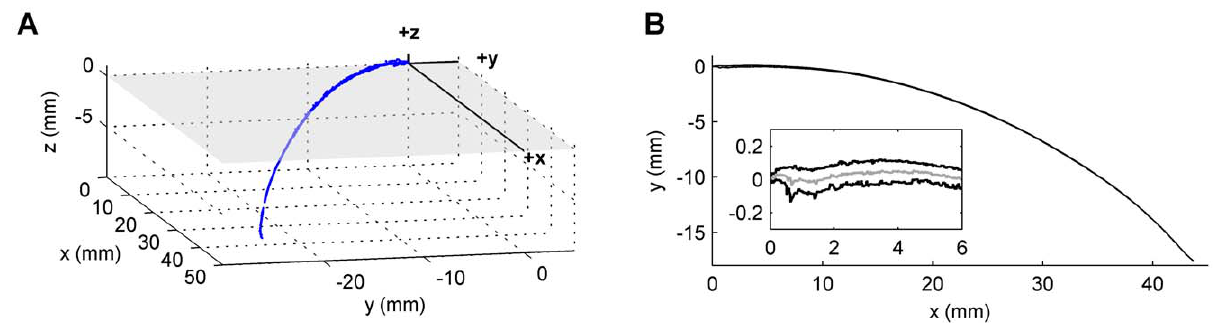
Figure 13. Experimental dataset and standard orientations. ( A ) An example whisker (right B1), extracted in 3D from the scanned rat head shown in Figure 1A of Results. ( B ) Shape of the whisker extracted from the 2D scan. The inset shows a magnified portion of the whisker with both x and y axes in units of mm. The light gray line is the centerline.